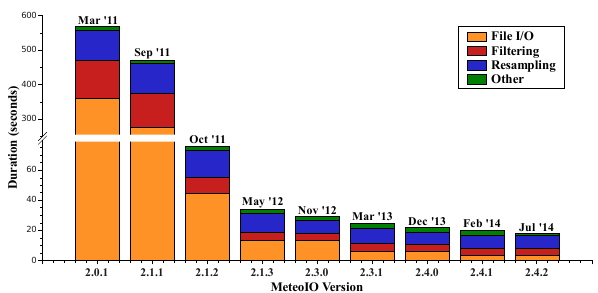
Figure 10. Performance increase in MeteoIO (March 2011 until February 2014).